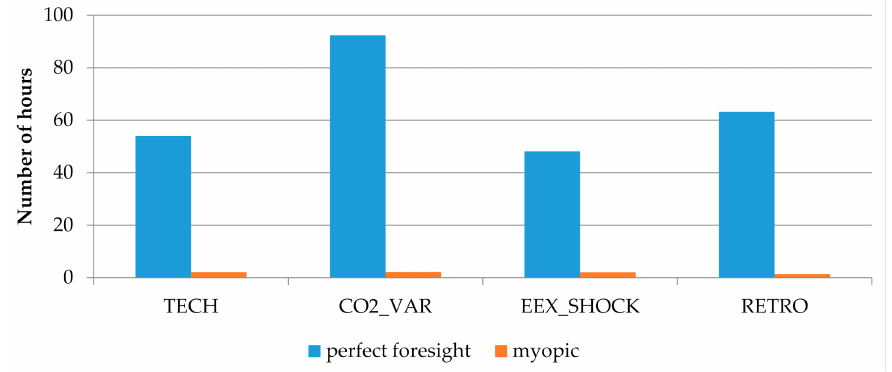
Figure 14. Duration of the optimization runs for the complete time horizon in